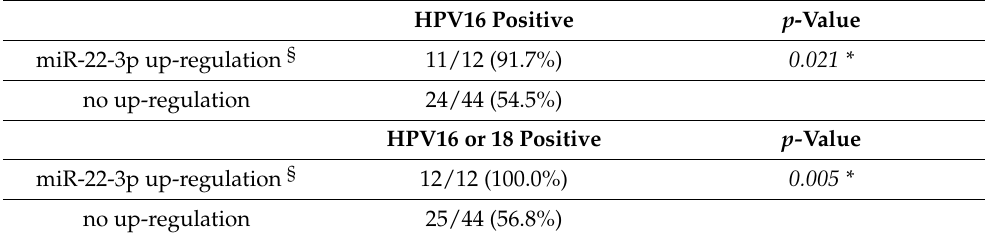
Table 4. The correlation between HPV16- and HPV16- or 18-infection and miR-22-3p expression. HPV16 Positive p -Value